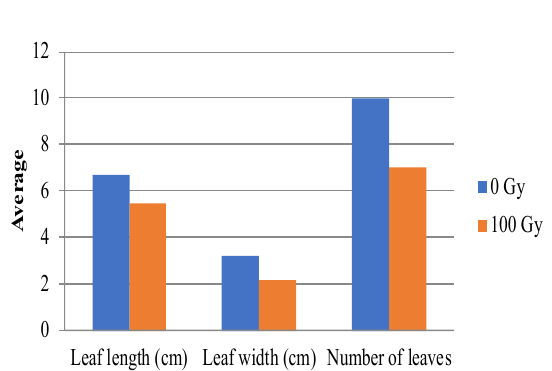
Figure 7.Effects of 100 Gy gamma irradiation on the leaf characteristics of the M1 generation of coffee ( Coffea arabica L. var. typica) plants grown under nursery conditions on “Genova Farm,” San Ramon District, Department of Junín, Peru.